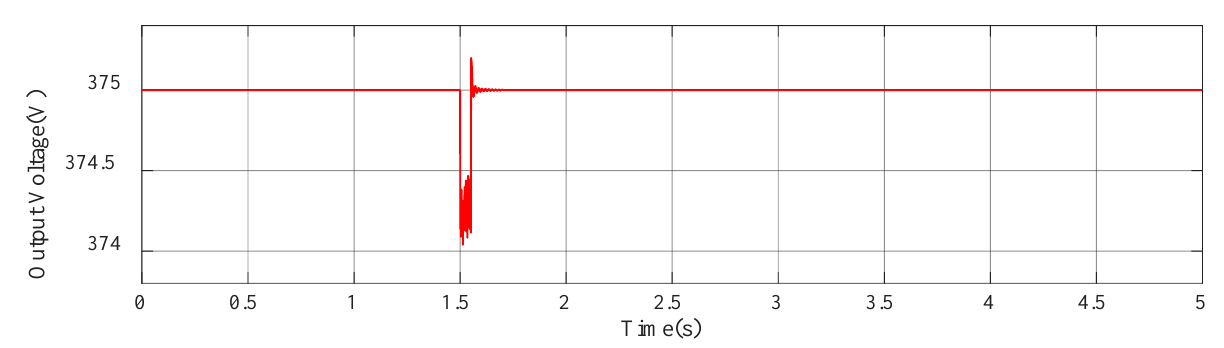
Figure 22. Battery Power.